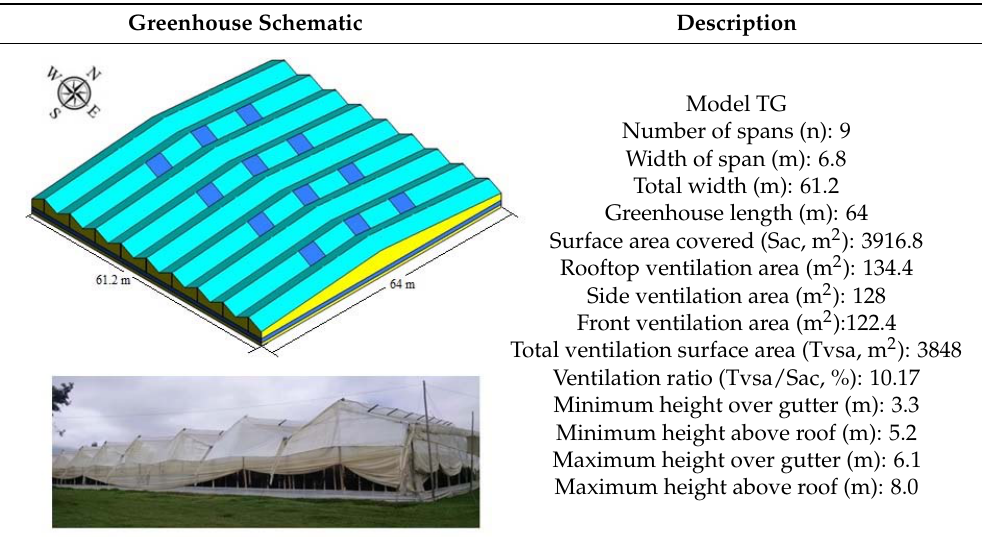
Table 1. General characteristics of the TG greenhouse.